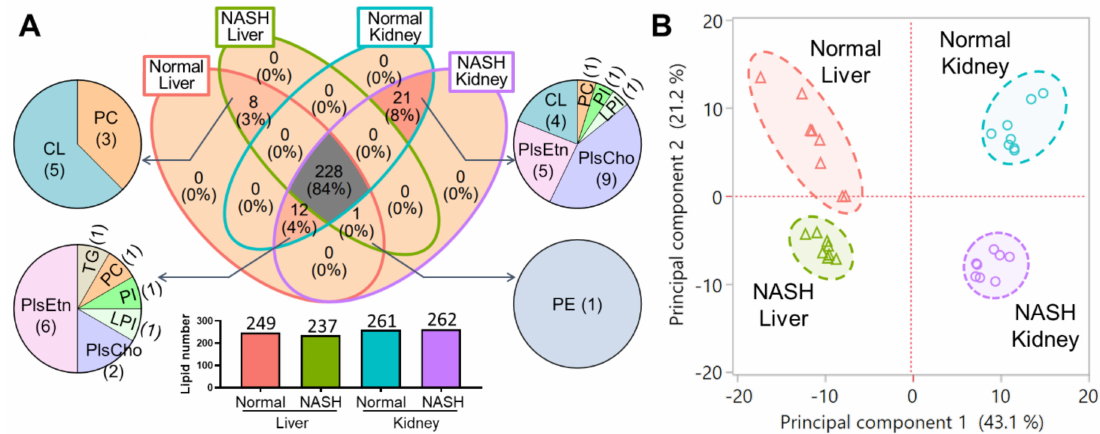
Figure 1. ( A ) Comparison for the diversity of the intact lipids among four groups: Normal liver (249), NASH liver (237), Normal kidney (261), and NASH kidney (262). Numbers represent the detected lipids in the sample. ( B ) Score plot of PCA revealed the distinguished profile of the intact lipids in liver/kidney tissues and normal/NASH